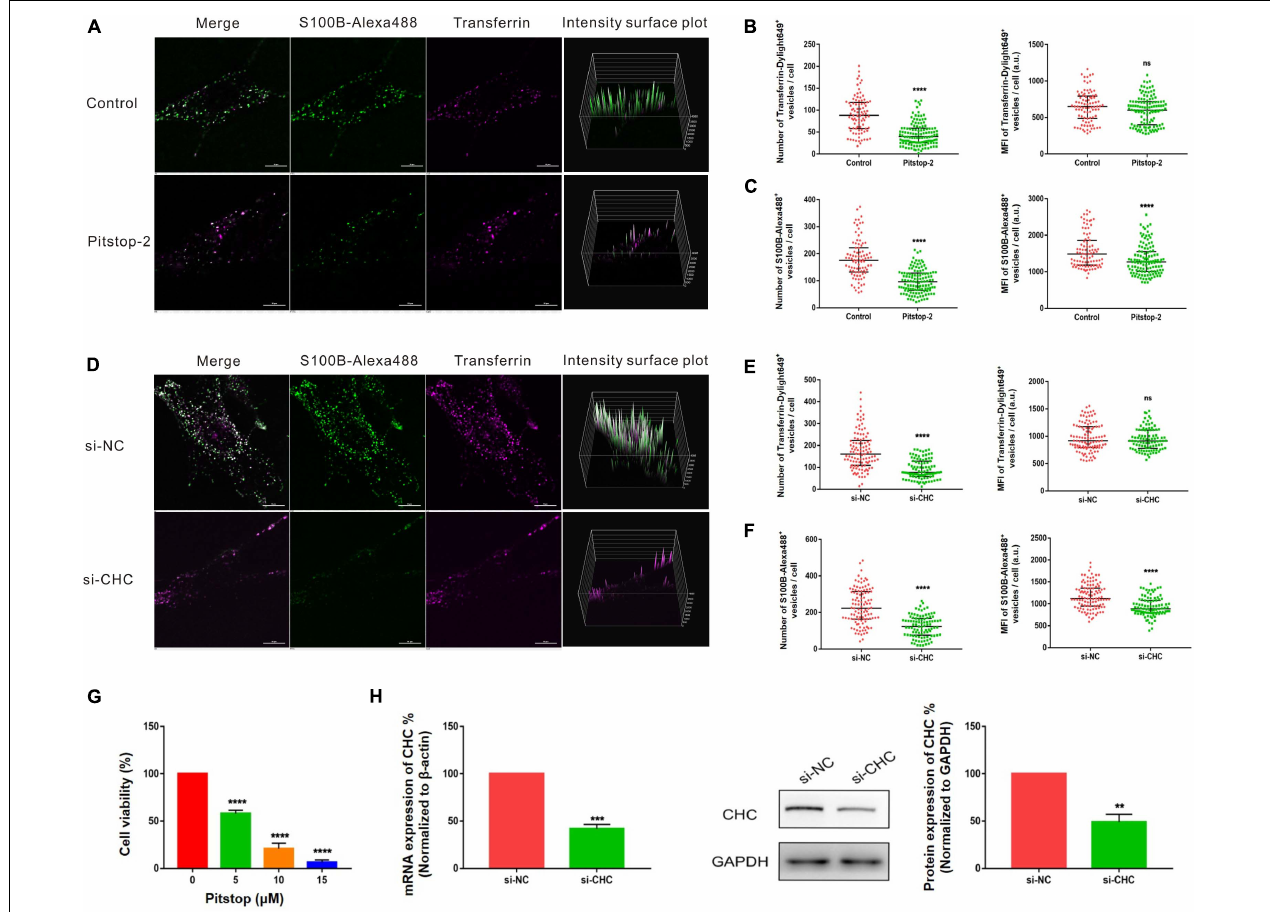
FIGURE 5 | Internalization of S100B-Alexa488 by MSCs is partially dependent on clathrin. (A–C) Effects of pitstop-2 on the uptake of S100B-Alexa488 and Transferrin-Dylight649. MSCs were pretreated with pitstop-2 or DMSO and then incubated with S100B-Alexa488 (0.1 µ M) and Transferrin-Dylight649 (15 µ g/ml) for 2 h. (A) Representative live cell confocal images. Scale bar, 10 µ m. (B,C) Quantified data showing the number and MFI of (B) Transferrin-Dylight649- and (C) S100B-Alexa488-positive vesicles. (D–F) Effects of siRNA-mediated CHC knockdown on the uptake of S100B-Alexa488 and Transferrin-Dylight649. MSCs were transfected with siRNA targeting CHC (si-CHC) or negative control siRNA (si-NC) for 72 h and then incubated with the two fluorescent probes for 6 h as described in section “Materials and Methods”. (D) Representative live cell confocal images. Scale bar, 10 µ m. (E,F) Quantified data showing the number and MFI of (E) Transferrin-Dylight649- and (F) S100B-Alexa488-positive vesicles. Data are presented as the median and interquartile range (IQR), n (control) = 88 cells; n (pitstop-2) = 121 cells; n (si-NC) = 107 cells; n (si-CHC) = 95 cells. All the experiments were repeated for three times. (G) Cell viability detected with CCK8 assays after being treated with the indicated concentrations of pitstop-2 for 2.5 h. (H) Relative mRNA and protein levels of CHC in cells transfected with si-CHC or si-NC. Data are the means of at least three independent experiments (mean ± SEM). Statistical analysis was done using t -tests; ** P < 0.01, *** P < 0.001, **** P < 0.0001, ns, not significant versus the control